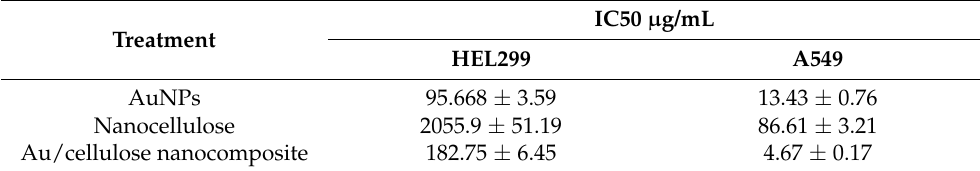
Figure 7. Cell viability rate of normal lung fibroblast HEL299 and lung cancer cells A549 that were pre-treated with different concentrations of AuNPs, nanocellulose, and Au/cellulose nanocomposite. Table 1. IC50 values of AuNPs, nanocellulose, and Au/cellulose nanocomposite on normal lung fibroblast HEL299 and lung cancer cells